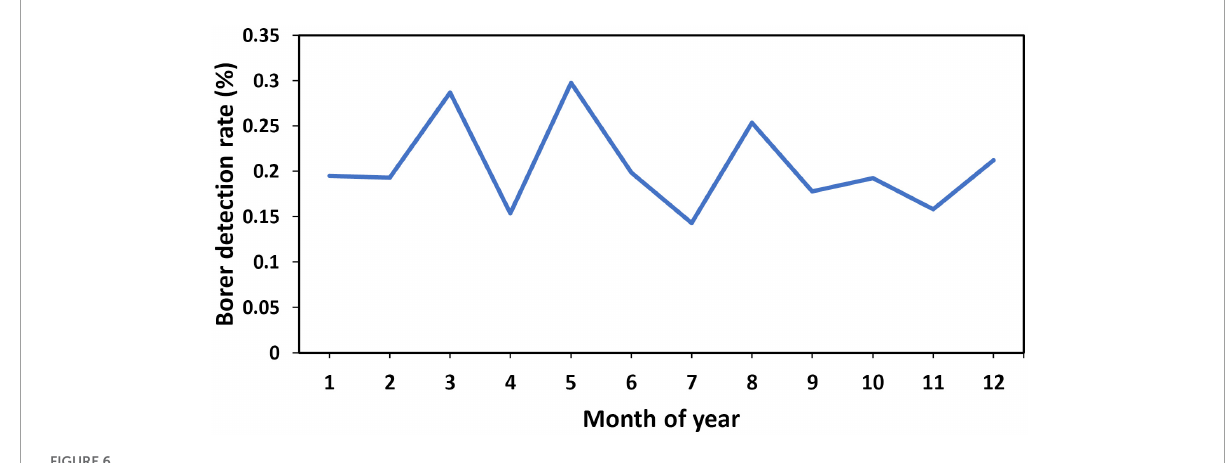
FIGURE6 Percentage of AQIM records with WPM in which borers were detected by month of year for inspections conducted at US ports during 2003–2020.